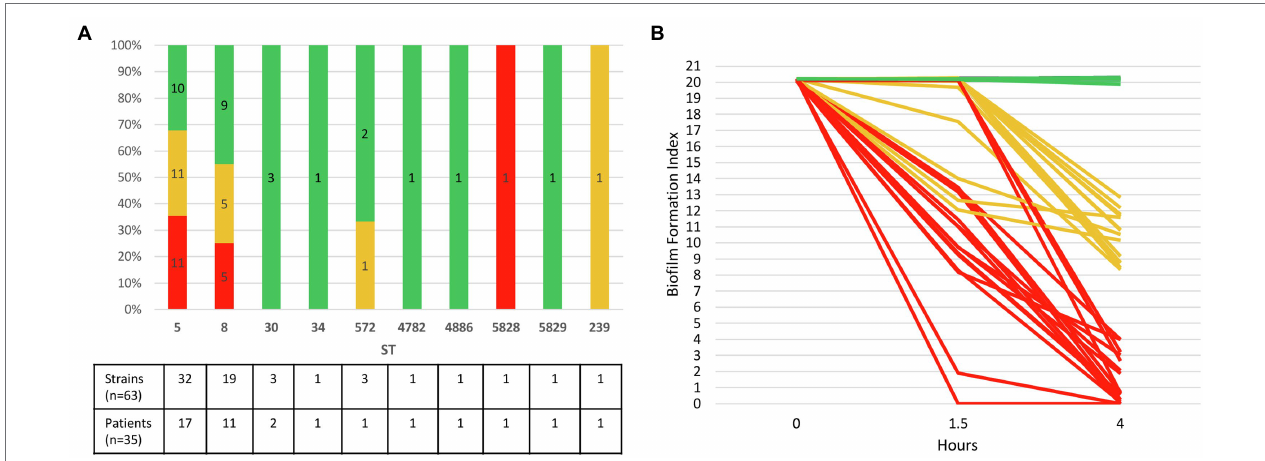
FIGURE 2 | Ability of 63 CF MRSA strains to form early biofilm according to MLST genotype. (A) Relative distribution of strains according to their genotype MLST (ST, sequence type) and their ability to form early biofilm as shown in (B) . The number of strains and patients are indicated at the bottom of the figure for each ST. (B) Dynamics of early biofilm formation determined using BRT ® and filtered ASM after 1.5 and 4 h of incubation. Red, strains with low biofilm index (BFI) values ( ≤ 4) associated with full immobilization of the magnetic beads due to complete biofilm formation; green, non-adherent strains (BFI values: 19.9–20.3); orange, strains with intermediate BFI values